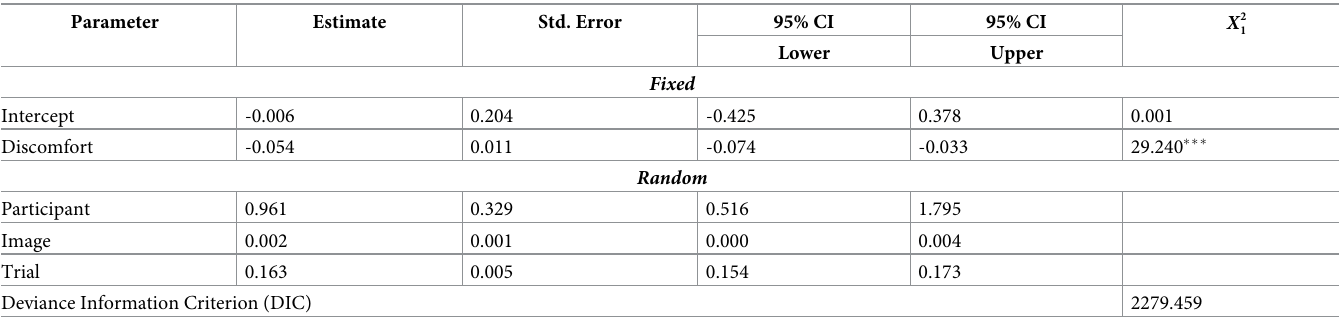
Table 4. Fixed effects estimates (top) and random effect variance estimates (bottom) for the model with best fit (Model 2a; Table 3).